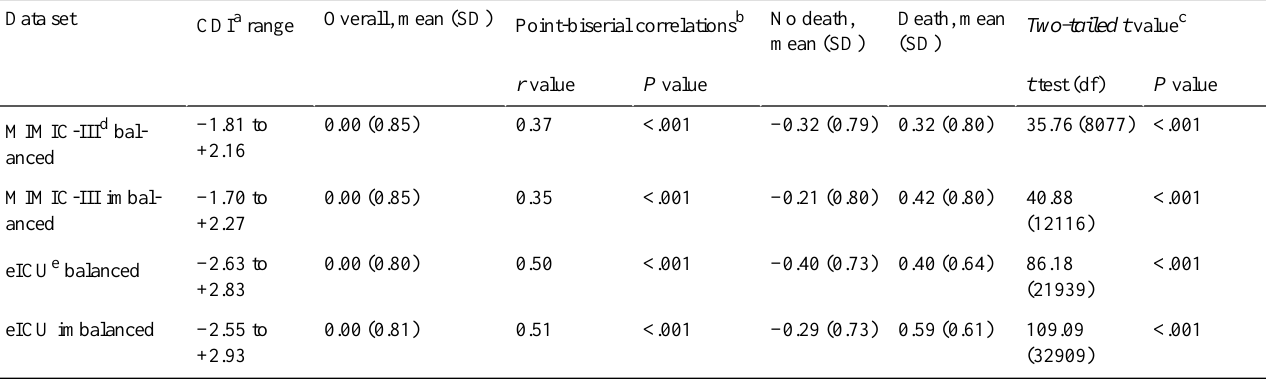
Table 3. Item response theory case classification difficulty index